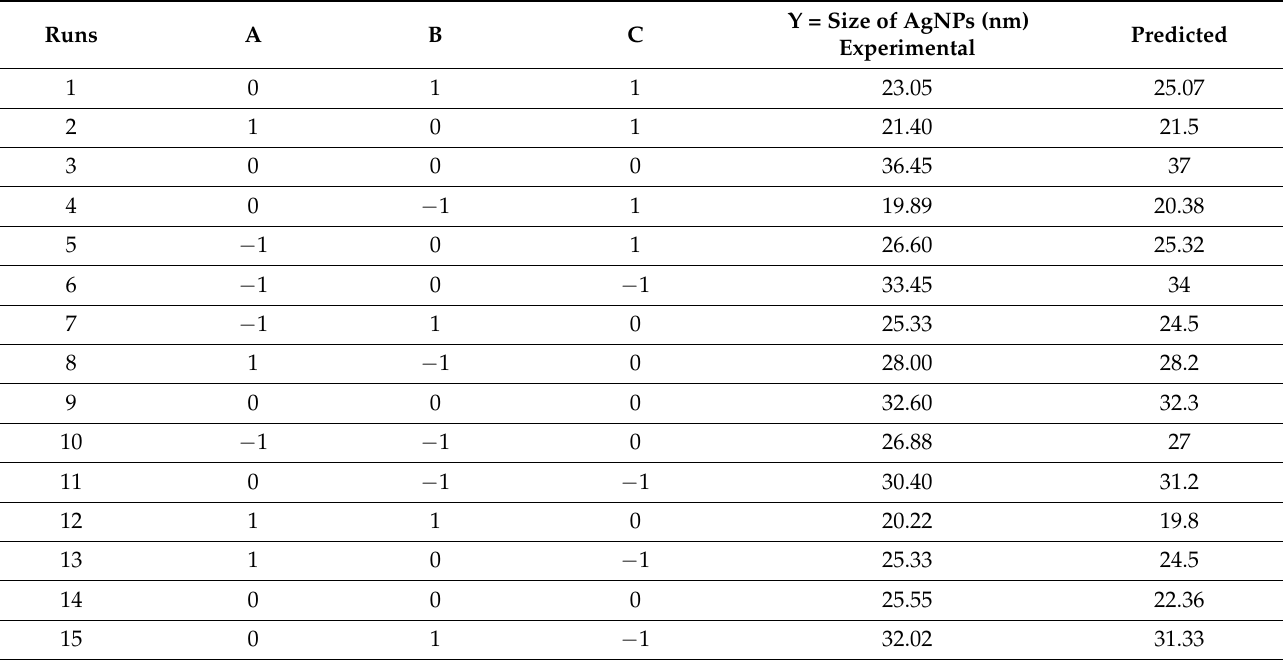
Table 1. Coded values with experimental and predicted responses obtained from a Box–Behnken experimental